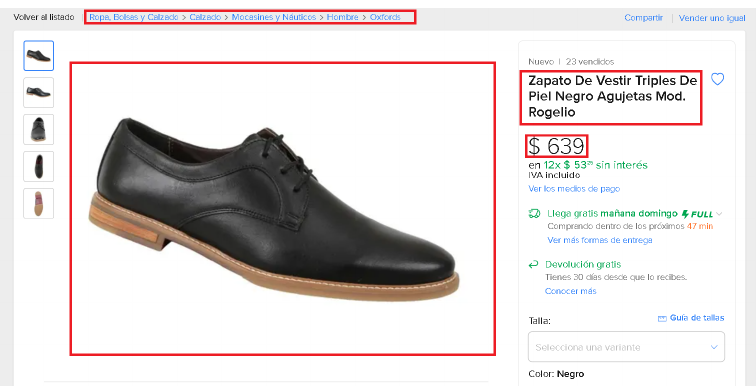
Figure 1. Example of e-shop 1 product. Title, brand, category, price and image.